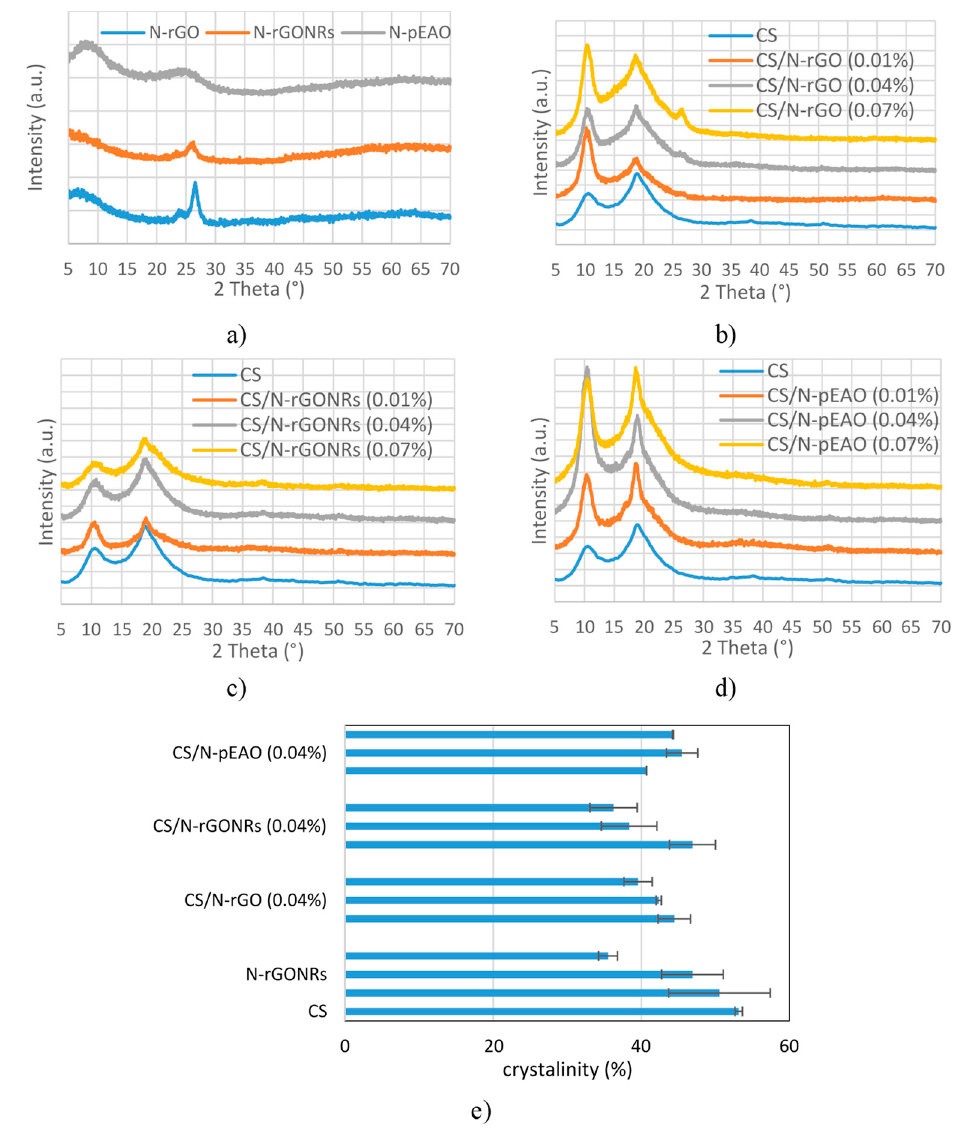
Figure 6. XRD patterns of ( a ) N-rGO, N-GONRs and N-pEAO and CS/graphene composites, containing 0.01% to 0.07% of ( b ) N-rGO, ( c ) N-rGONRs, ( d ) N-pEAO, and ( e ) calculated crystallinity index (CrI 020 = ( I 020 − I am )/ I 020 × 100 and CrI 110 = ( I 110 − I am )/ I 110 × 100), where I 110 represents the maximum absorption intensity during 18–20 ◦ , and I 110 represents 11 ◦ [23]. The CS spectrum was added as control ( b – d